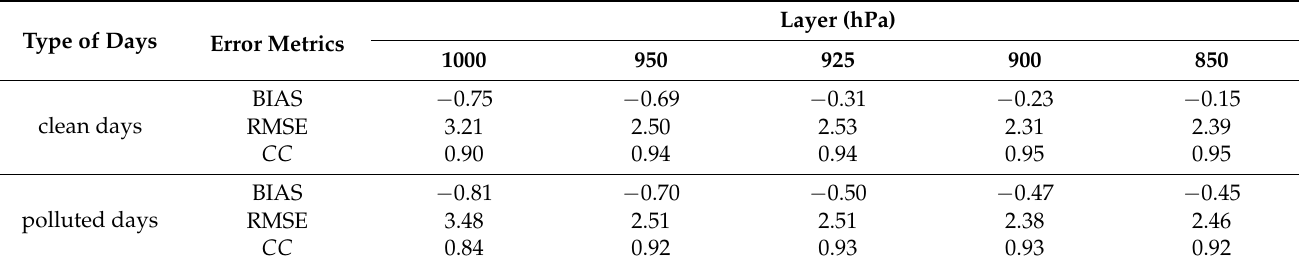
Table 3. Error metrics for the temperature in Beijing.